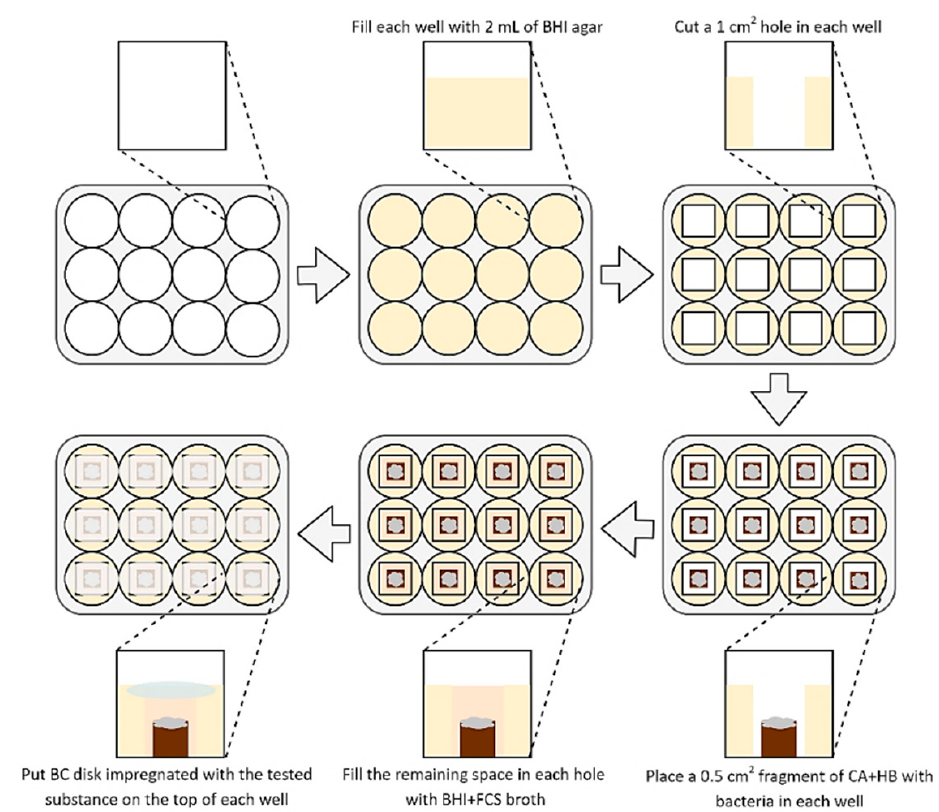
Figure 1. Diagram presenting a method used to determine an antimicrobial activity of tested substances released from BC carriers against 3-day lawn biofilm H. pylori cells. Abbreviations: BHI agar, Brain Heart Infusion agar; BHI + FCS broth, Brain Heart Infusion broth with 7% foetal calf serum; CA + HB, Columbia agar with 7% hemolysed horse blood.